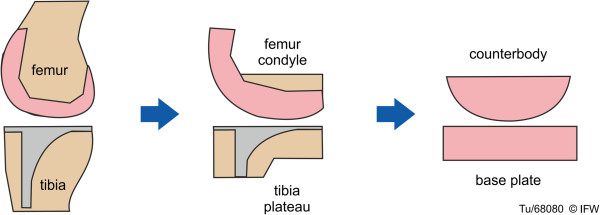
Development of simplified implant geometry [24],[25].